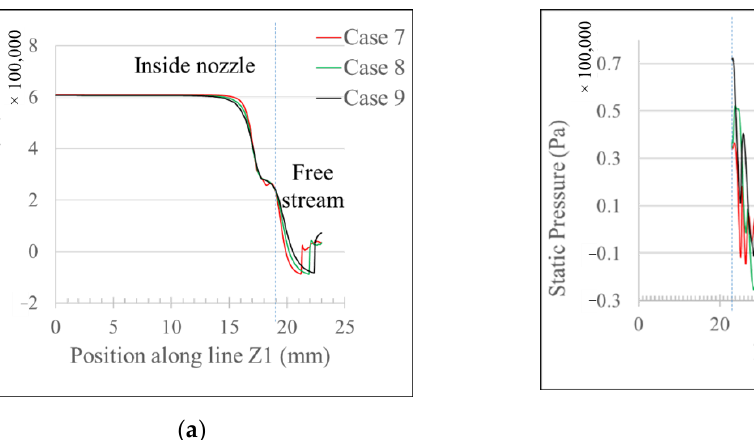
Figure 13. Pressure distribution curve for various nozzle configurations in kerf slot (l offset = 6 mm): ( a ) along line Z1 and ( b ) along line Z2.